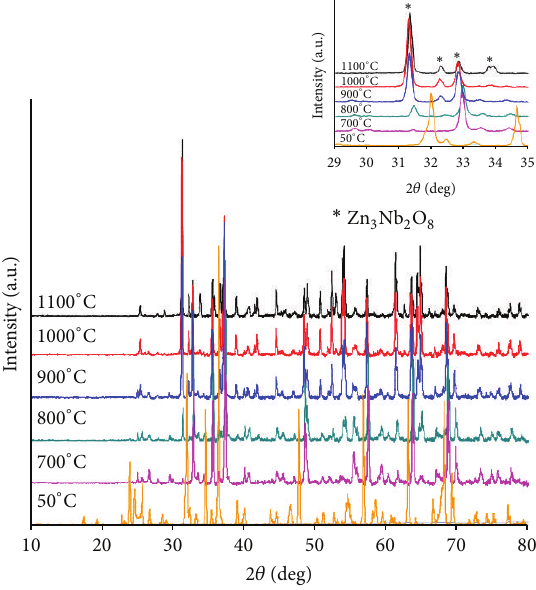
Figure 1: XRD patterns of Zn 3 Nb 2 O 8 . A magnified zone of the XRD patterns containing the most intense peak was